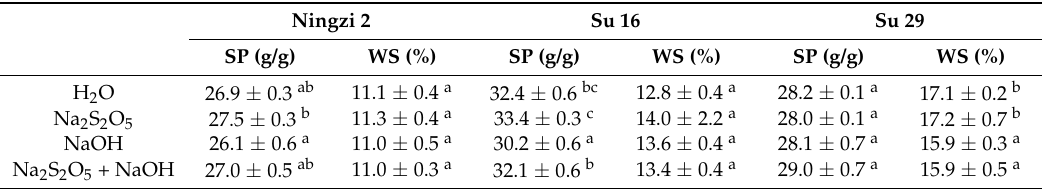
Table 5. Swelling powers (SP) and water solubilities (WS) of